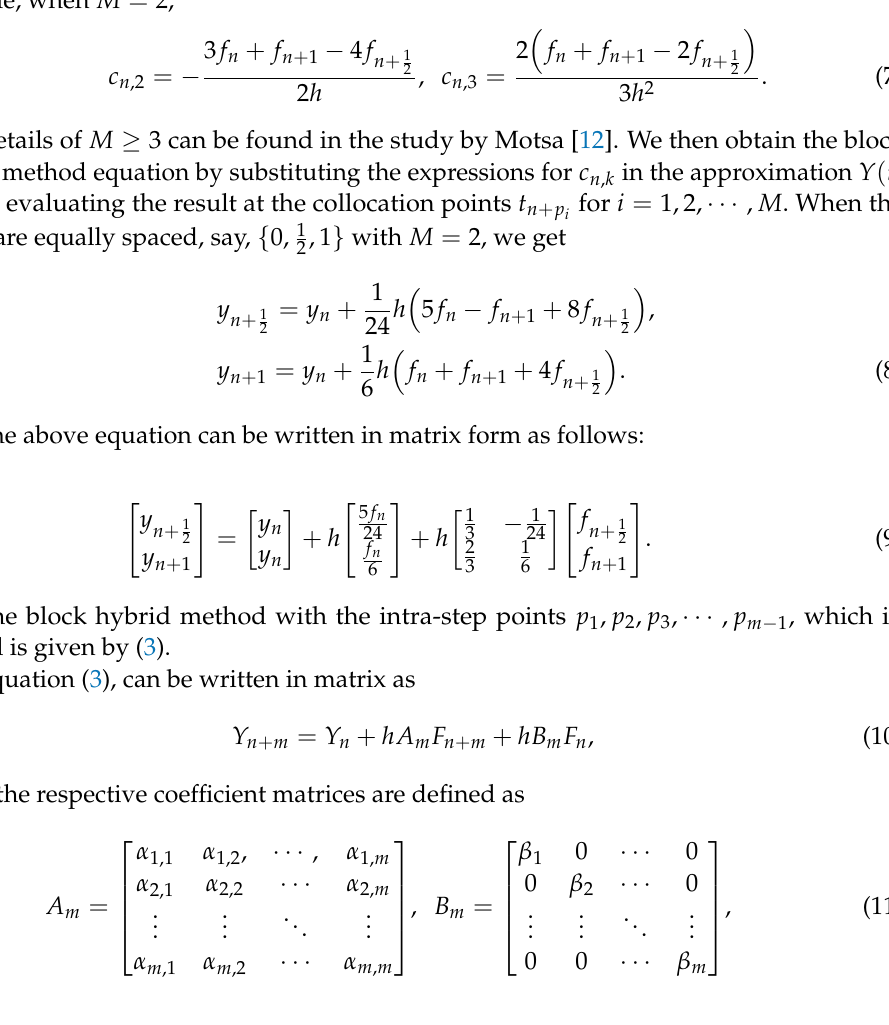
equations Table [( D [ Y , t ] / t → t n + p unknowns = Table [ c n , i , { i , θ , M + 1 } ] ; c n , θ ≈≈ y n